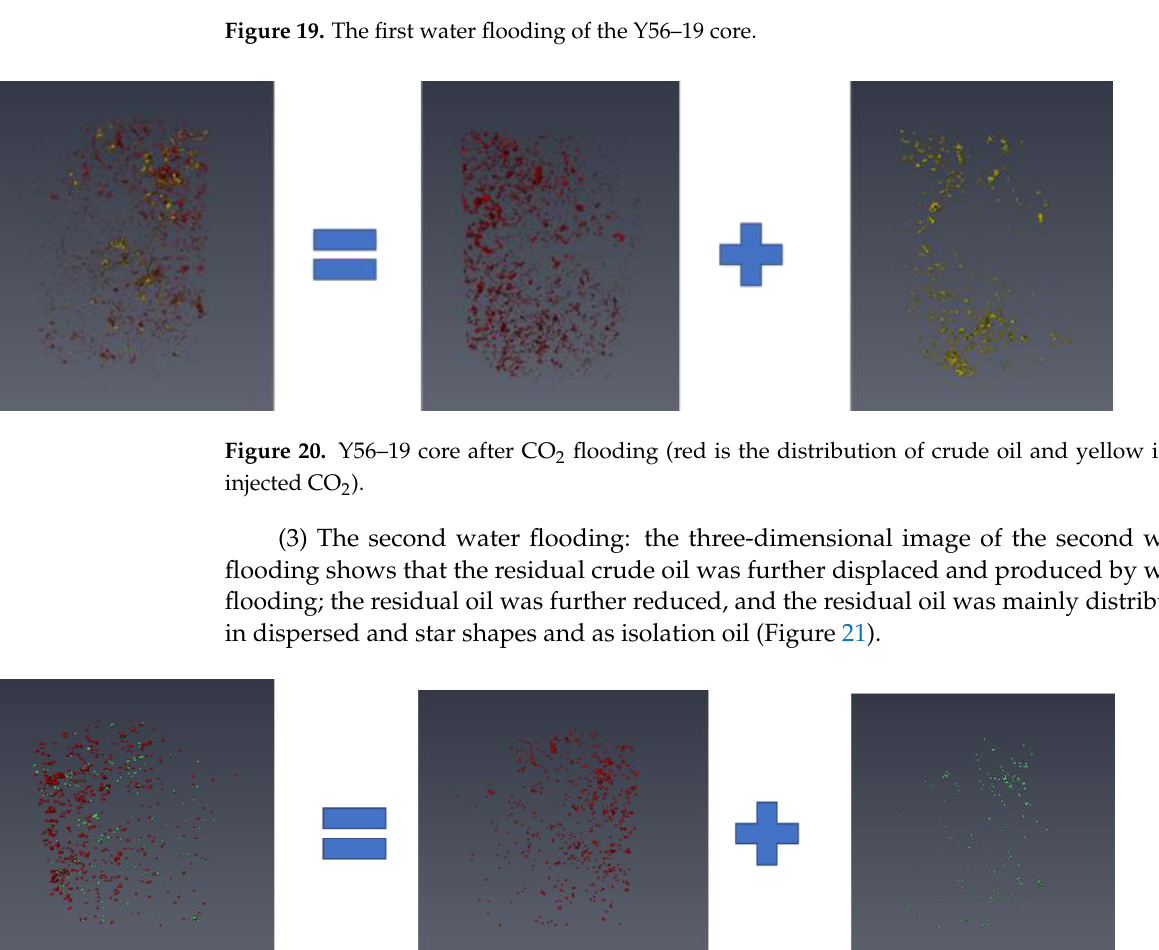
Figure 19. The first water flooding of the Y56 – 19 core.